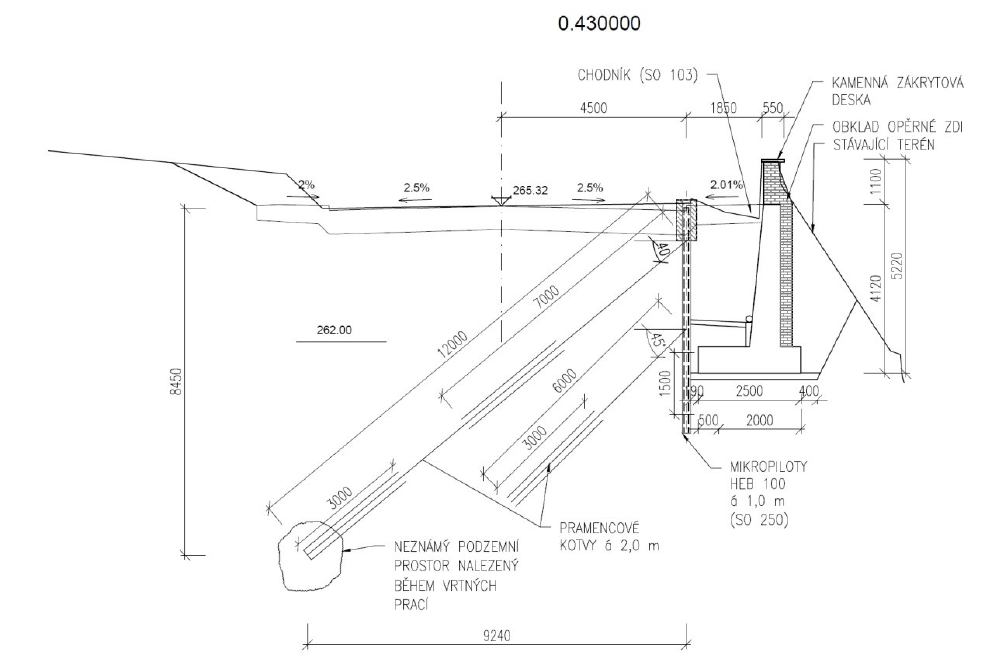
Figure 1. Underground space